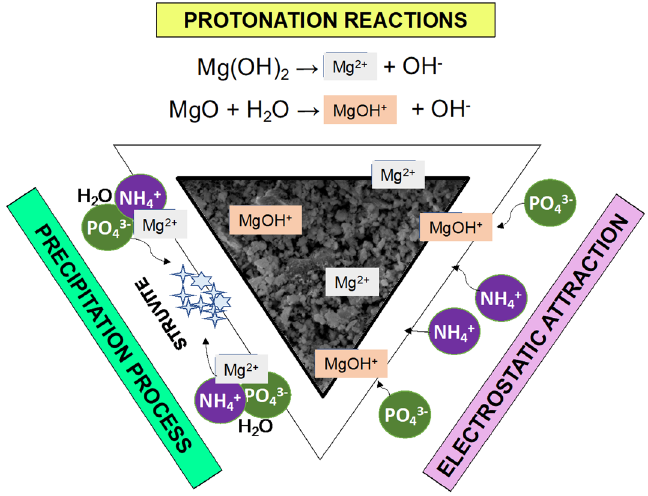
Figure 5. Possible mechanisms for struvite formation and deposition on Mg-laden microalgal biochar